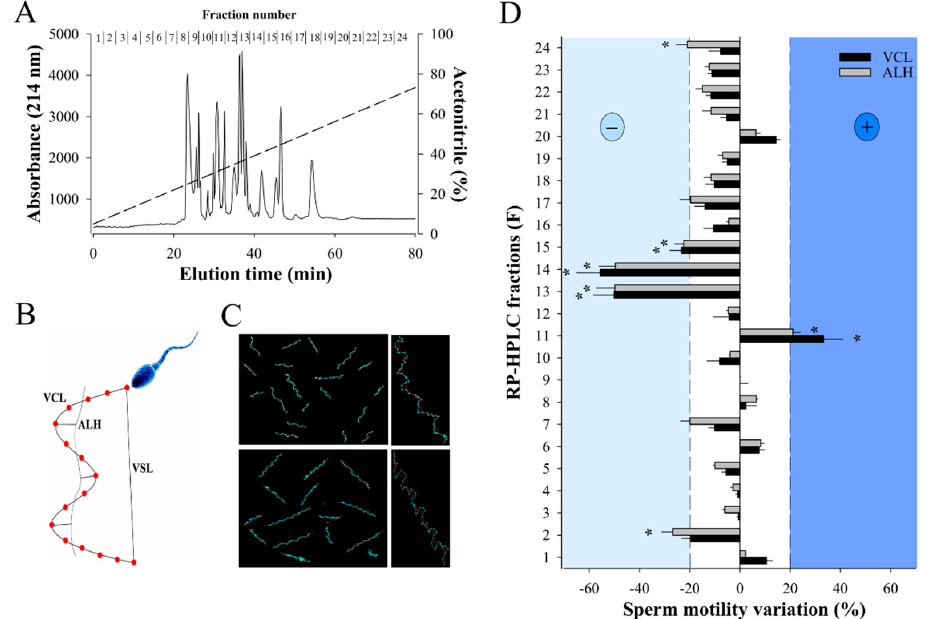
Figure 1. E ff ect of W. aegyptia venom primary fractions on OF1 mice sperm motility. ( A ) Chromatogram of the analytical C18 RP-HPLC fractionation of the Egyptian snake venom into 24 fractions. Fractions numbers are indicated on top. Dashed line represents the linear ACN gradient. ( B ) Schematic diagram illustrating the di ff erent sperm motility parameters that were calculated by the CASA system: VCL and VSL corresponding to curvilinear velocity and straight-line velocity, respectively, and ALH corresponding to the lateral displacement of sperm head. ( C ) Examples of sperm trajectories as visualized by the CASA system. Top panel: control sperms; bottom panel: 10 min F11-treated sperms. Right panels: 10 × magnification on a single sperm. ( D ) Primary screening of the bioactivity of all RP-HPLC fractions on sperm motility parameters VCL and ALH. Fractions that arbitrarily produced ± 20% variation in these parameters were further considered. Results were normalized to mean variation produced by control condition. * p < 0.005.